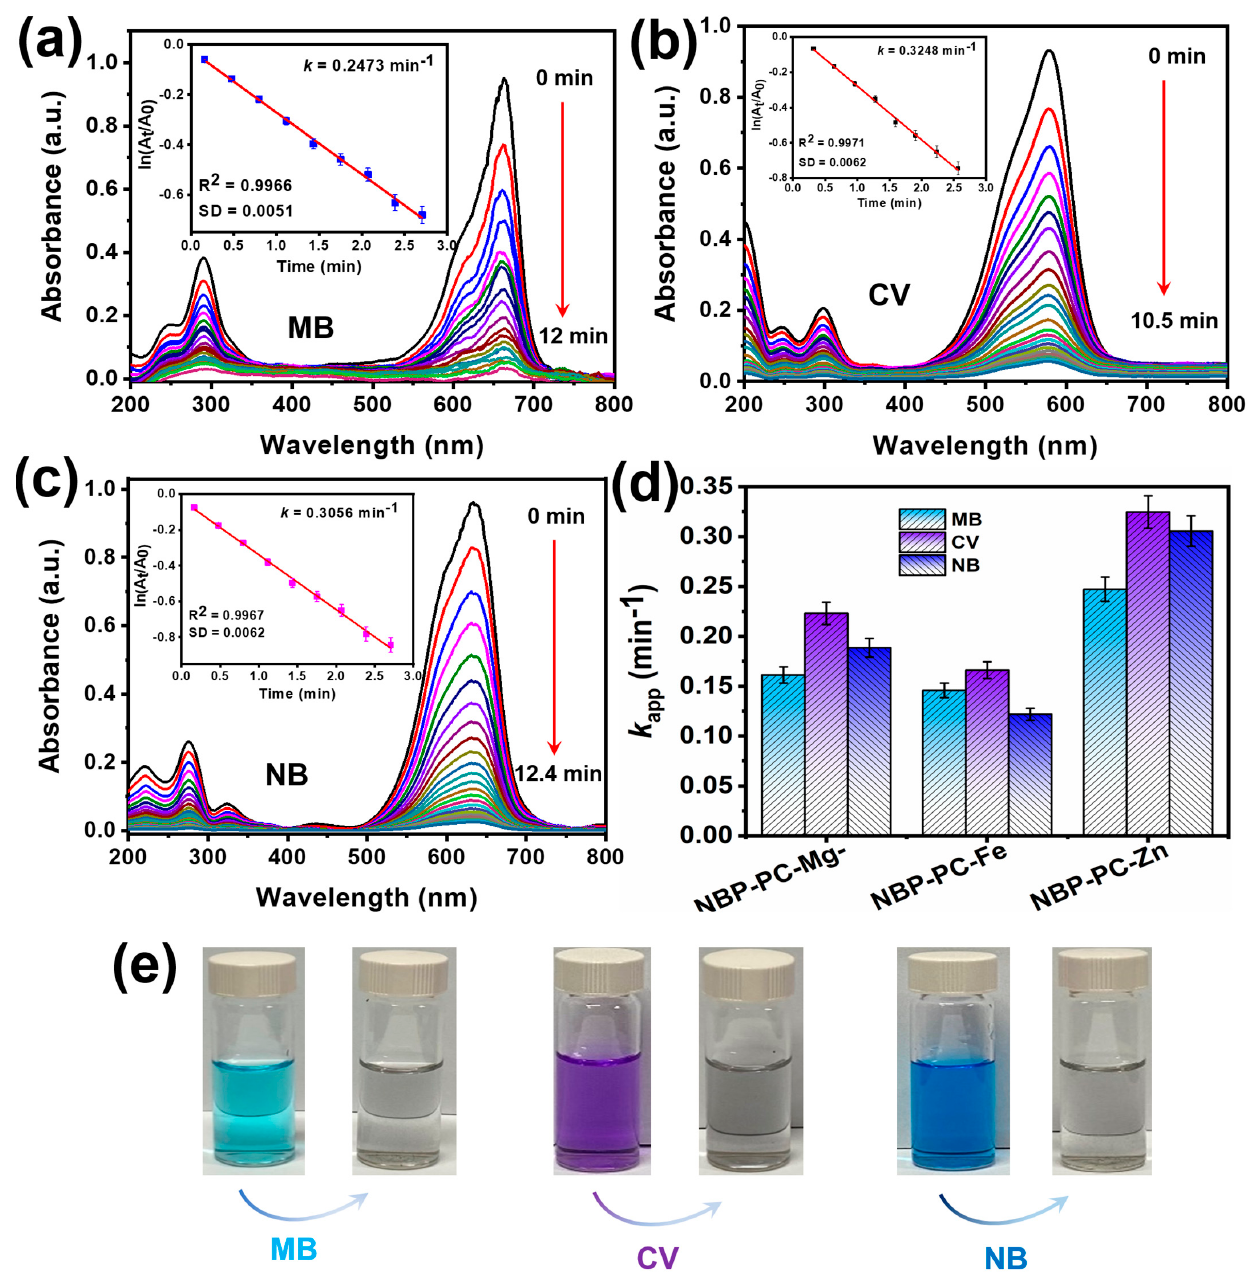
Figure 6. UV–visible absorption spectra of ( a ) MB, ( b ) NB, ( c ) CV after the addition of NaBH 4 in the presence of NBP-PC-Zn (0.6 mg) catalyst, ( d ) the photographs of colour changes after the dye reductions. ( e ) the matching colour changes that occurred after the reduction in MB, CV, and NB dyes. Reduction in MB was selected as a model reaction here in order to assess metal-free reduction catalyst and to improve the reaction conditions. The catalytic performances dur- ing the reduction in MB over several types of metal-free catalysts were also examined for comparison. A null reduction was typically produced from reactions when there was no NaBH 4 (hydrogen donor) supplied (entry 1, Figure S6). This was also true for reactions when there was no catalyst present. According to Table 2, bare DFC (entry 2, without chemical activation) showed very little ability to reduce MB dye, but chemically activated catalyst (PC-Zn, entry 3) likewise produced very little reduction, typically between 10 and